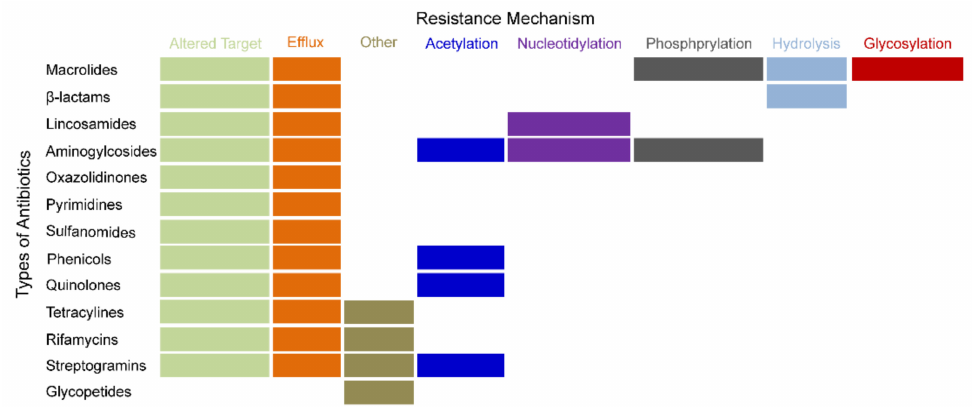
Figure 1. Classical drug-resistant mechanisms of common antibiotics. This figure was modified based on the Figure 1 of Dunn, et al. [31]. Labels in different colors stand for various drug-resistant